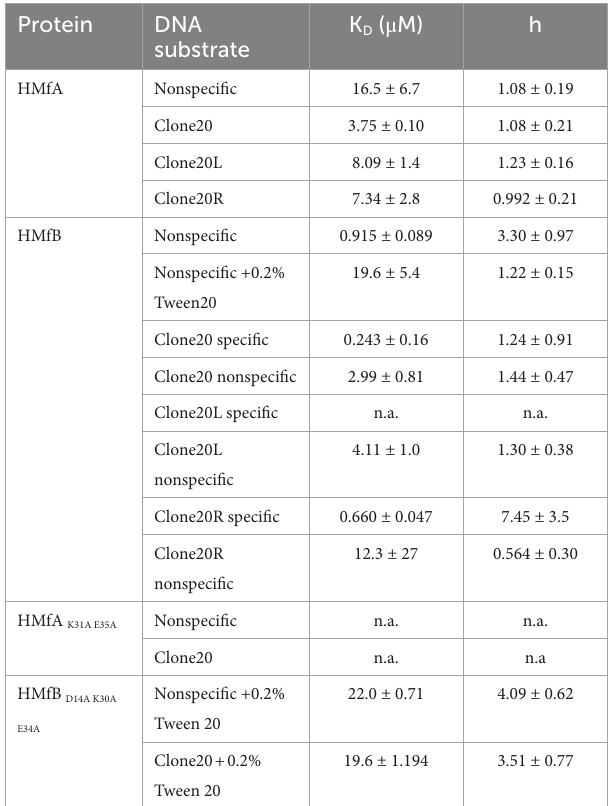
TABLE 1 Binding affinities (K D ) and Hill binding coefficients (h) of HMf to 78 bp DNA substrates. The values were determined by fitting of the MST data to the Hill binding